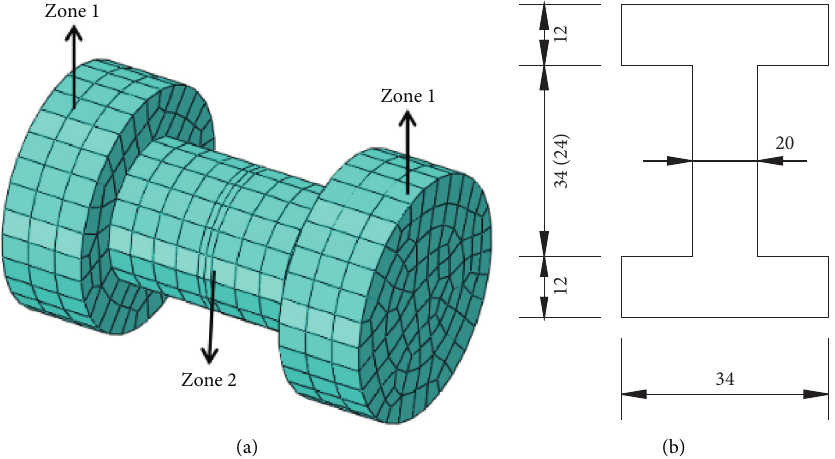
Figure 10: Components and dimensions of the FE geometry model of the bolt assembly. (a) Components. (b) Dimensions (in